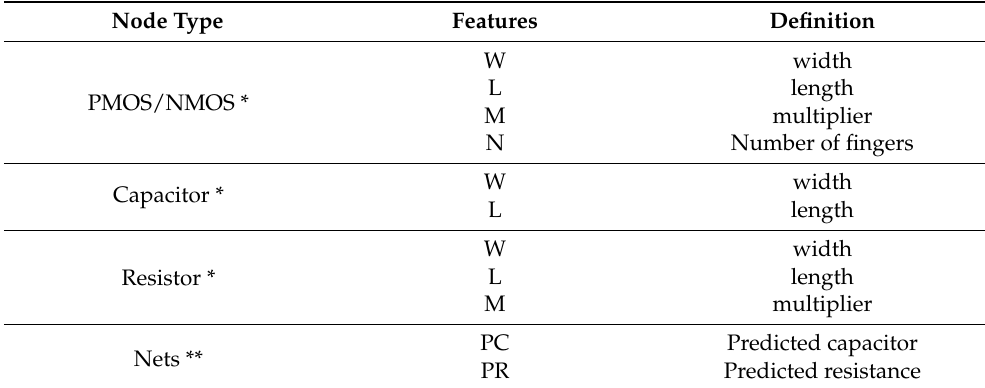
Table 1. Embedded features from the